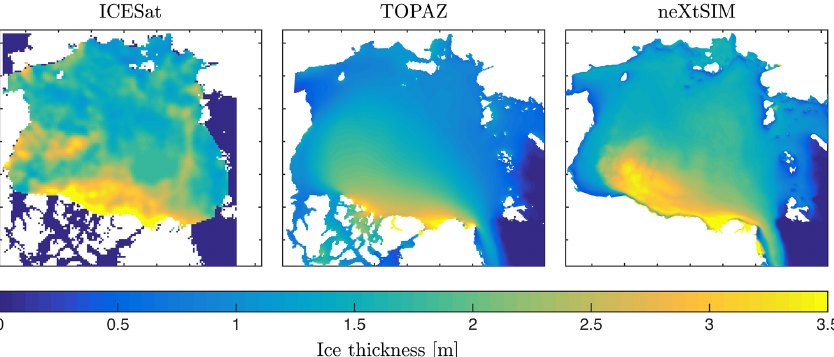
Figure 12. Mean ice thickness in the central Arctic obtained from ICESat satellite observations (Kwok et al., 2009) and the two models. ICESat results are only available in February and March of 2008, while the model results have been averaged over the winters of 2008, 2009 and